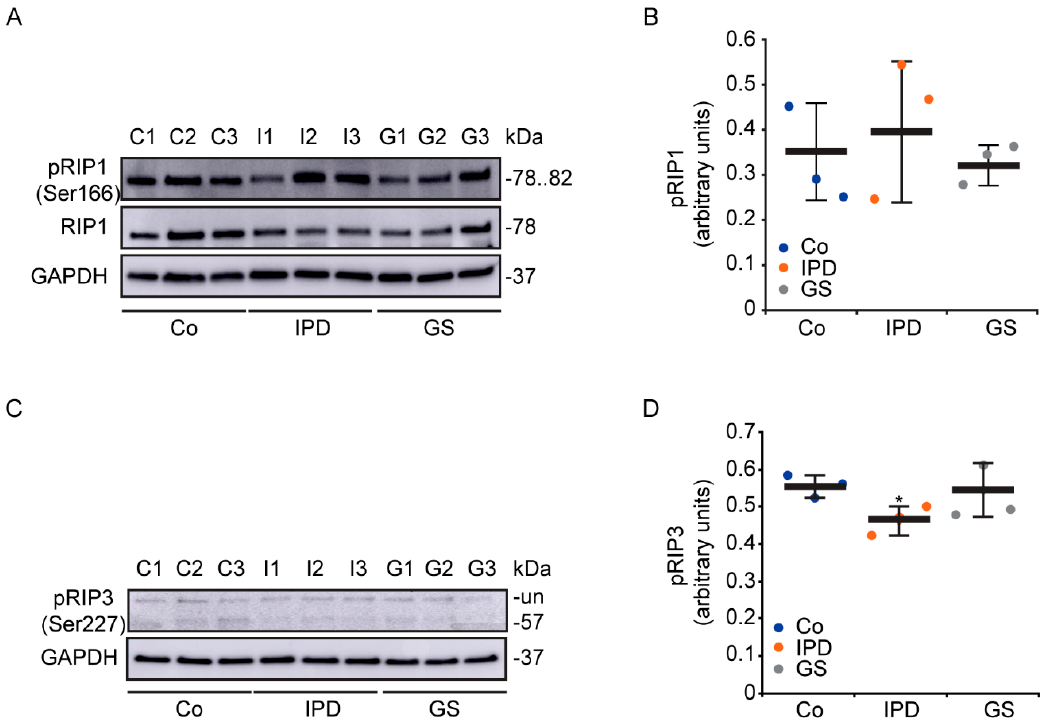
Figure 1. Necroptosis pathway in Parkinson’s disease (PD) patients. ( A – D ) Cells were maintained under basal conditions. Expression levels of p-receptor-interacting protein (RIP)1 ( A , B ) and p-RIP3 ( C , D ), which are involved in the signaling pathway of necroptosis, were determined and normalized to the loading control, GAPDH. Data are the value of the representative blot and correspond to the mean ± SD of three independent lines (* p < 0.05, compared to control (Co) lines). Each group consisted of three cell lines: control (C1, C2, and C3), idiopathic Parkinson’s disease (IPD: I1, I2, I3), and GS (PD patients with the G2019S LRRK2 mutation: G1, G2, G3) groups; un: unspecified. Experiments were done at least three times.